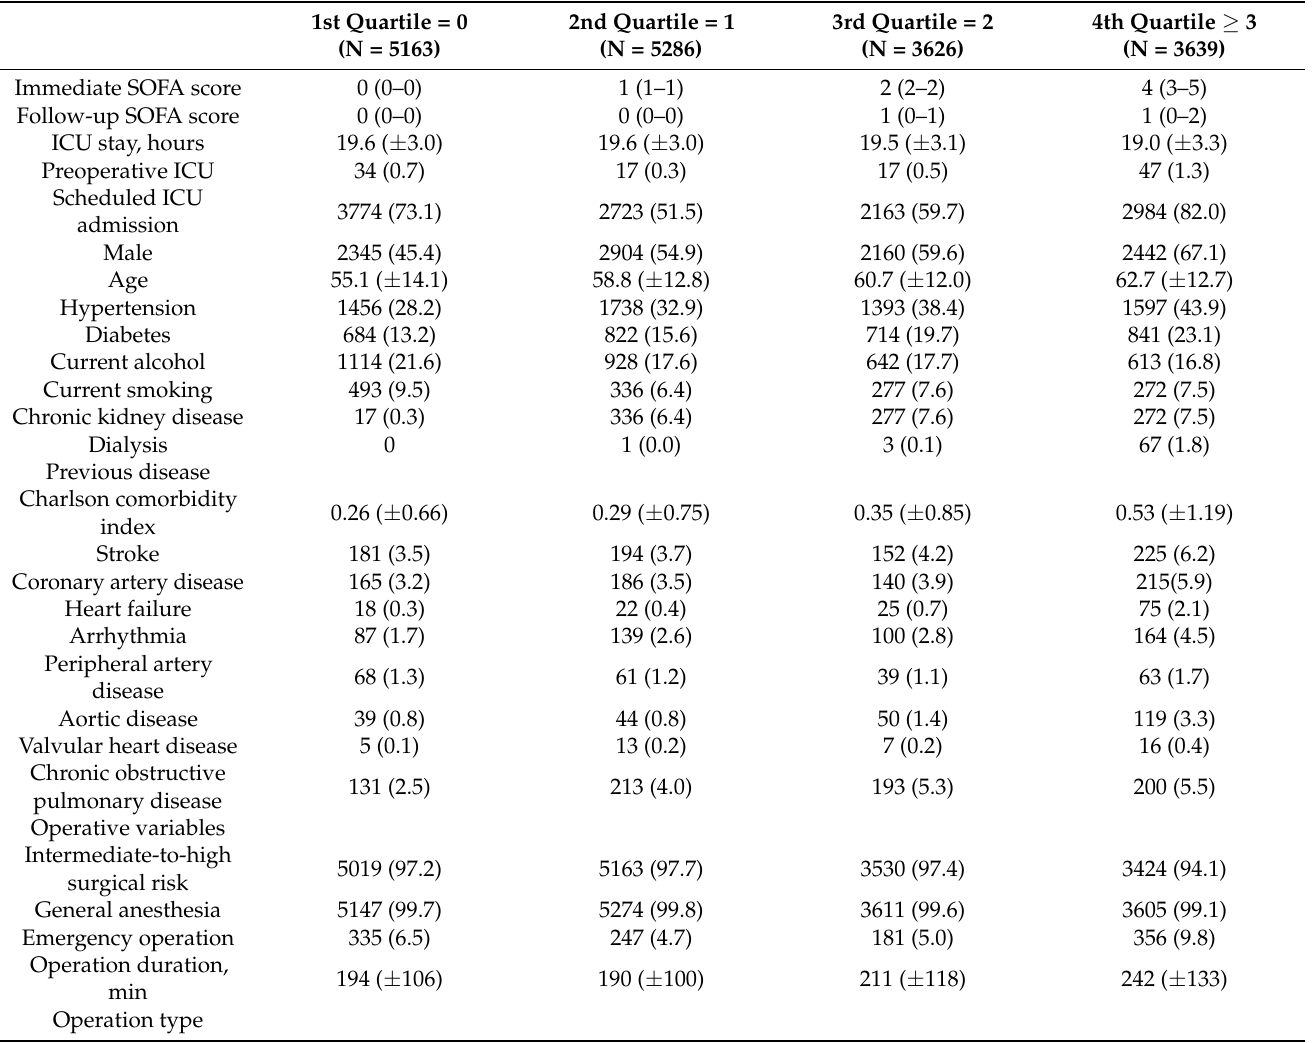
Table 1. Baseline characteristics and outcomes according to quartile values of SOFA score immediately after